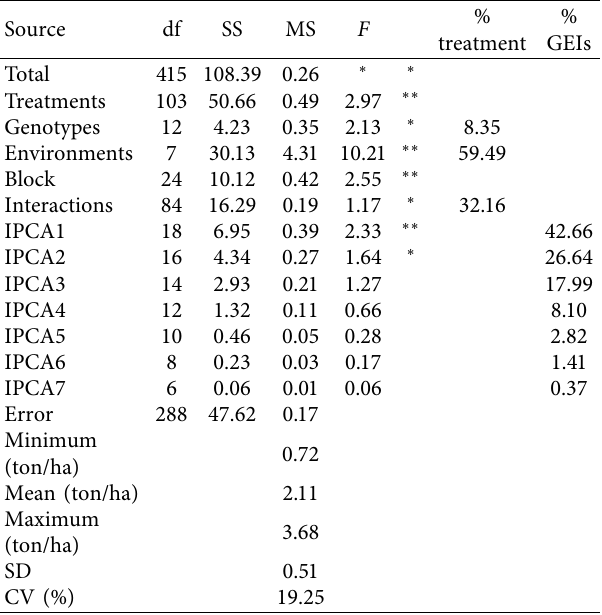
Table 3: Combined ANOVA and AMMI analysis of new promising soybean lines in eight